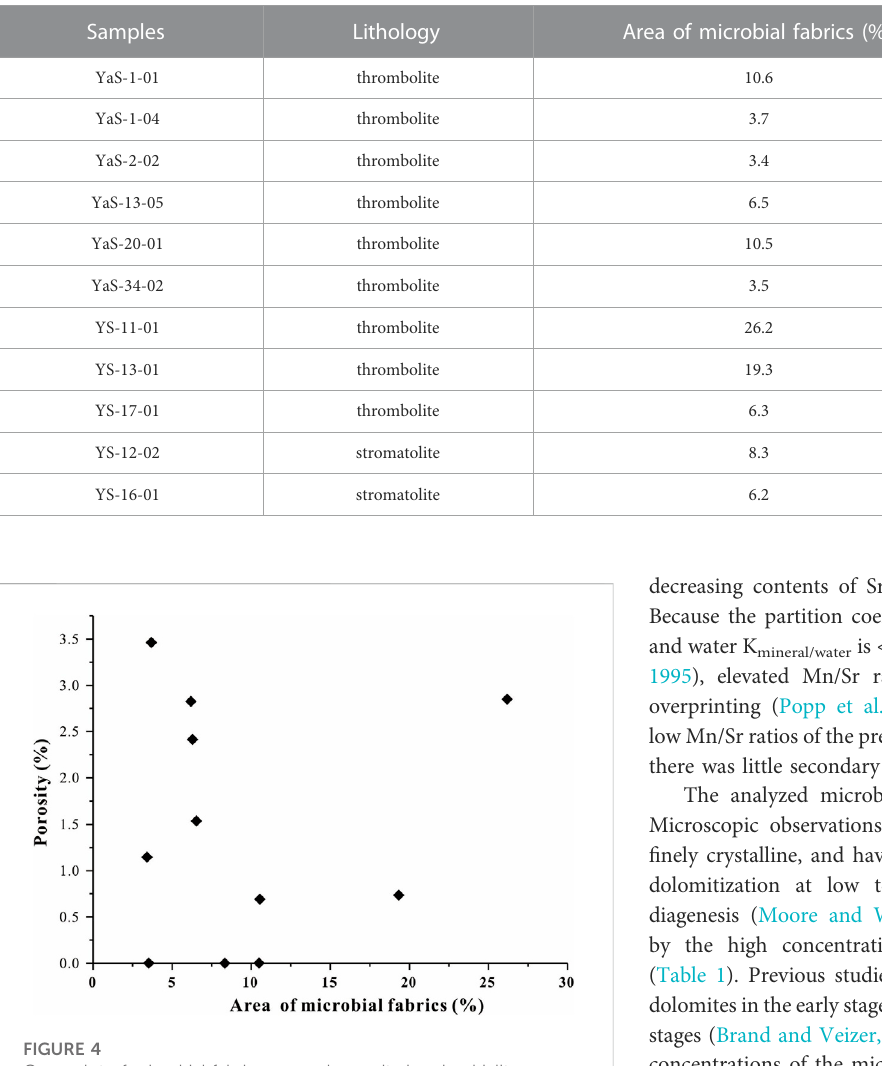
TABLE 2 Area of microbial fabrics and pores in microbialites.